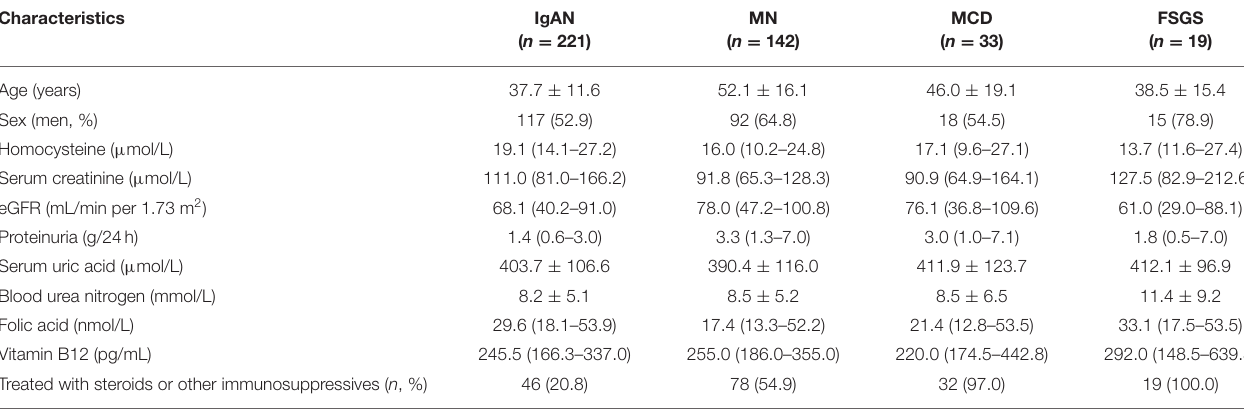
TABLE 1 | Baseline characteristics of patients with different primary glomerular diseases. Characteristics